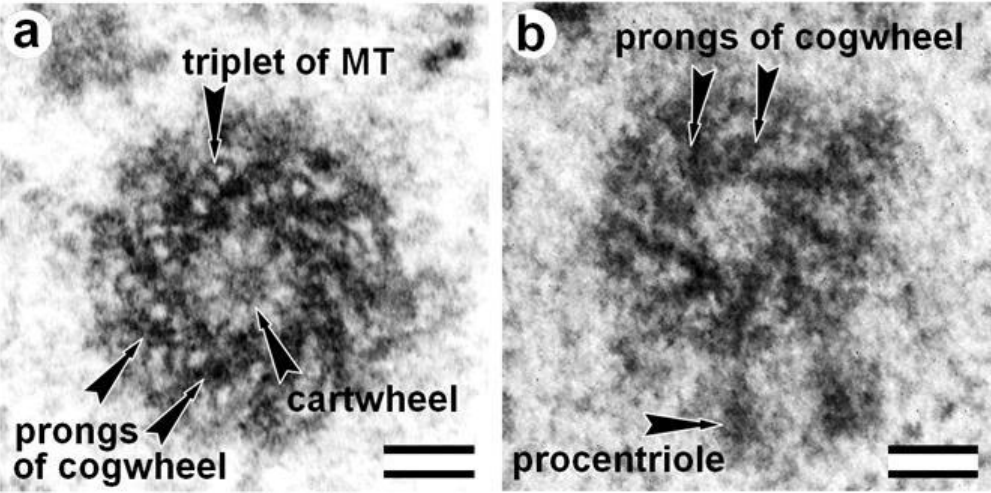
Figure 2. Centriole structure in larvae of two wasps: ( a ) larvae of Nasonia vitripennis, where prongs of cogwheel structure are visible between triplets of MT; and ( b ) early larvae of Anisopteromalus calandrae , where the centriole has a cogwheel without MT. The cartwheel structure is not clearly visible in the centriole lumen. View from the distal end of the centriole. Scale bar: 100 nm. From [20] with modifications.